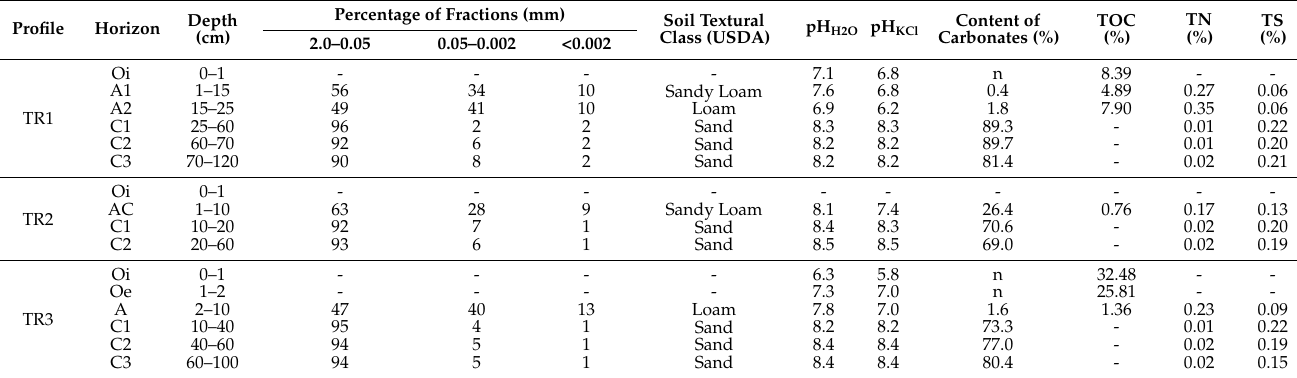
Table 3. Selected physical and chemical properties of soils.